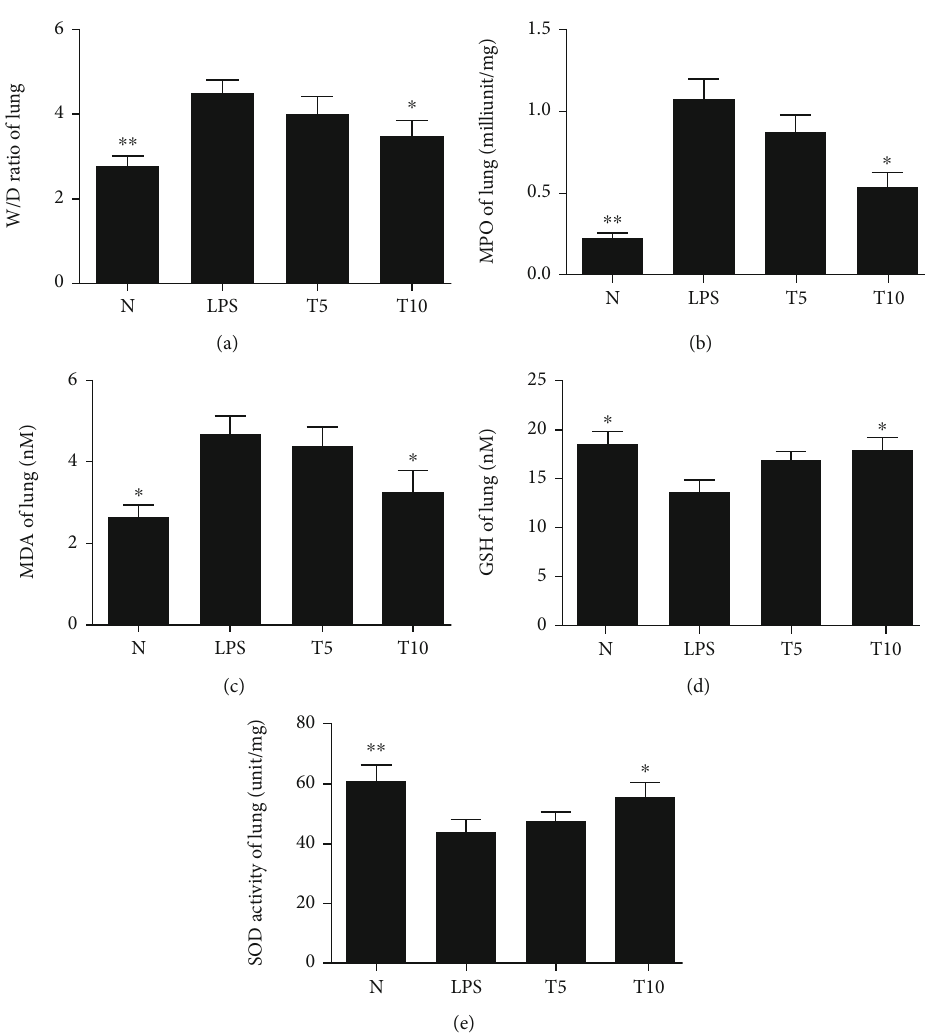
Figure 3: Tomatidine alleviated oxidative stress in LPS-induced lung injury. In the lungs, tomatidine regulated (a) the W / D ratio, (b) the MPO, (c) MDA, (d) GSH levels, and (e) SOD activity. Data are presented as the mean ± SEM . ∗ p < 0 : 05 and ∗∗ p < 0 : 01 vs. LPS group. N group: normal control mice; LPS group: LPS treatment only; T5 group: 5 mg/kg tomatidine plus LPS; T10 group: 10mg/kg tomatidine plus